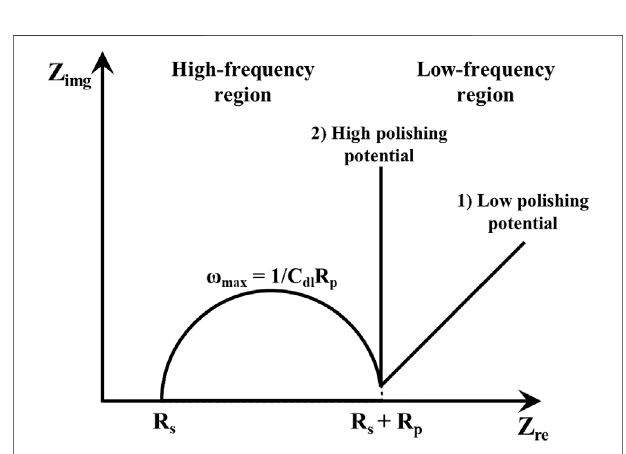
FIGURE 5 | Schematic Nyquist plot according to frequency